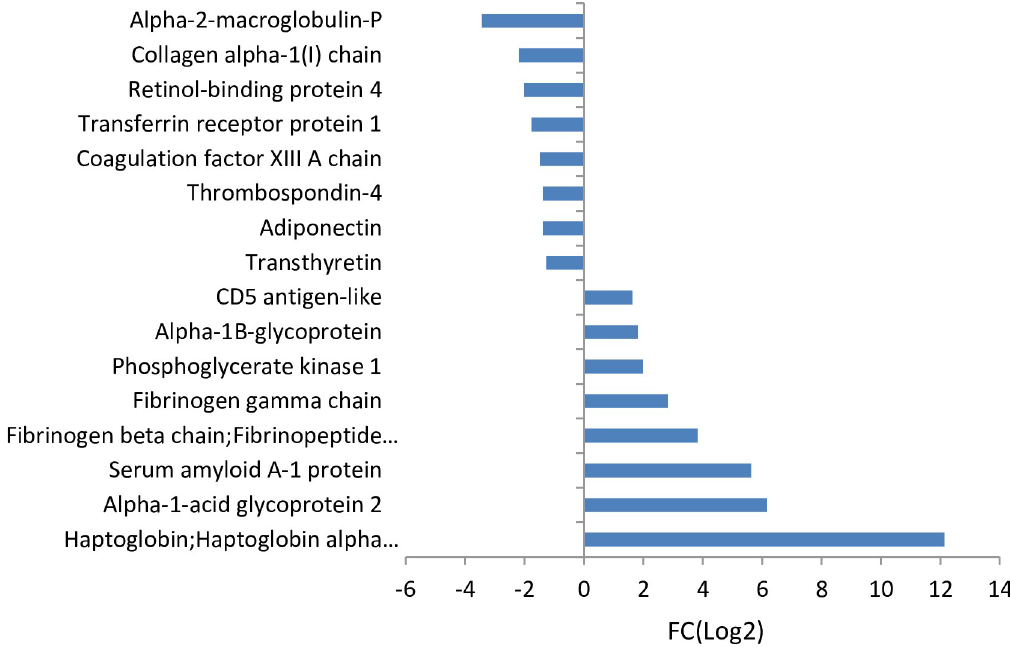
Fig 4. Protein fold changes (FC(Log2) � 1 or � -1) in plasma, metastasis (day 54) versus pre-metastasis (day 19) with p- value � 0.05 for Z- and t